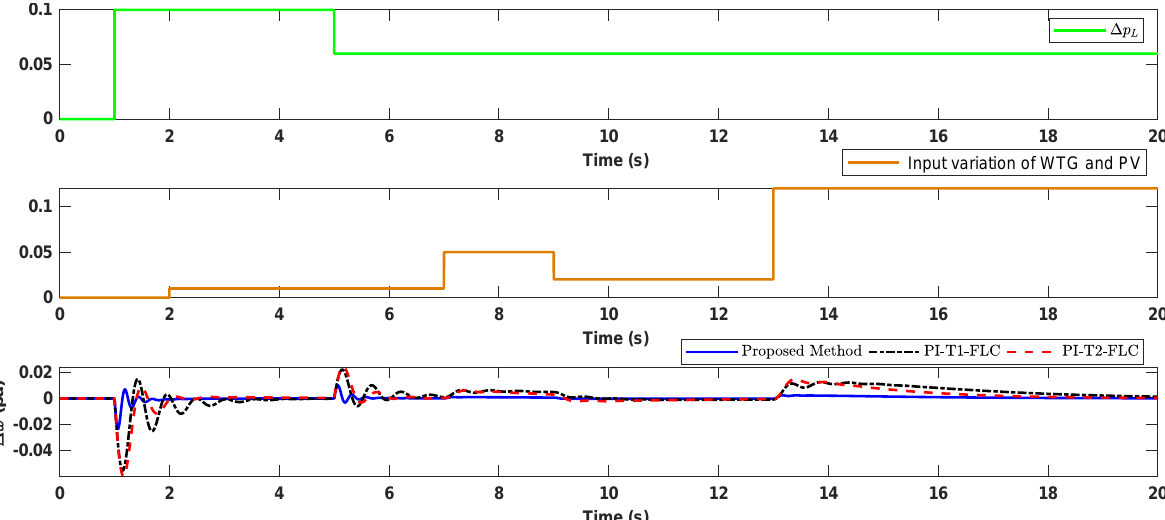
Figure 10. Example 1: Scenario 4: Frequency regulation performance in the presence of multiple load changes ( ∆ p L ) and time-varying solar radiation and mechanical power of wind